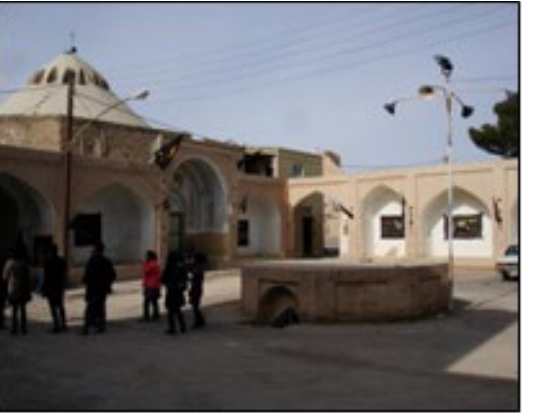
Fig. 6: Use sabats and Fig 6: Use sabats and shades Fig 6: Use sabats and shades